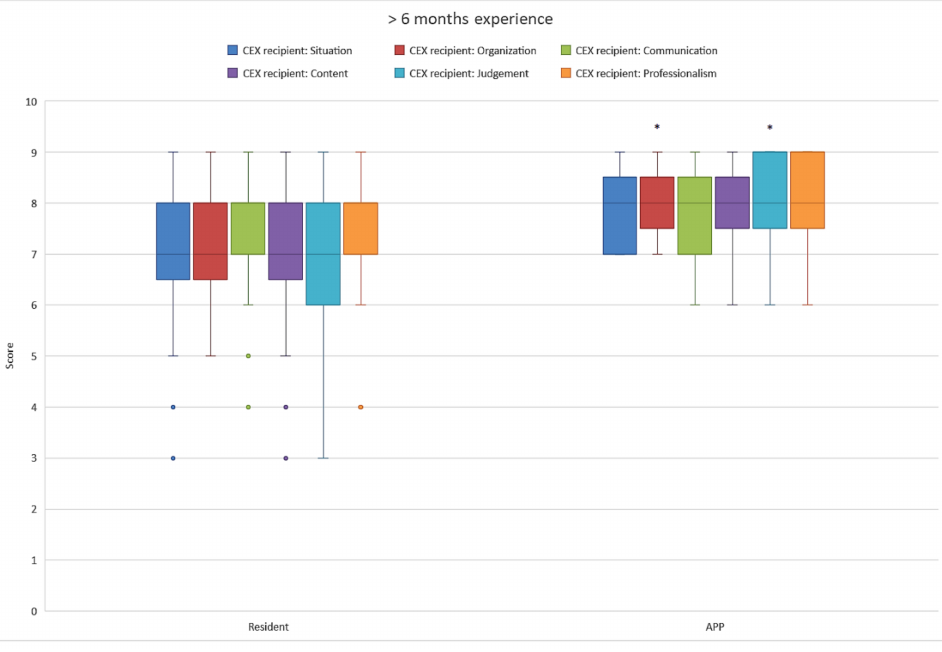
Figure 2. The handoff CEX recipient scores of MRs and APPs with more than 6 months experience. *: p <